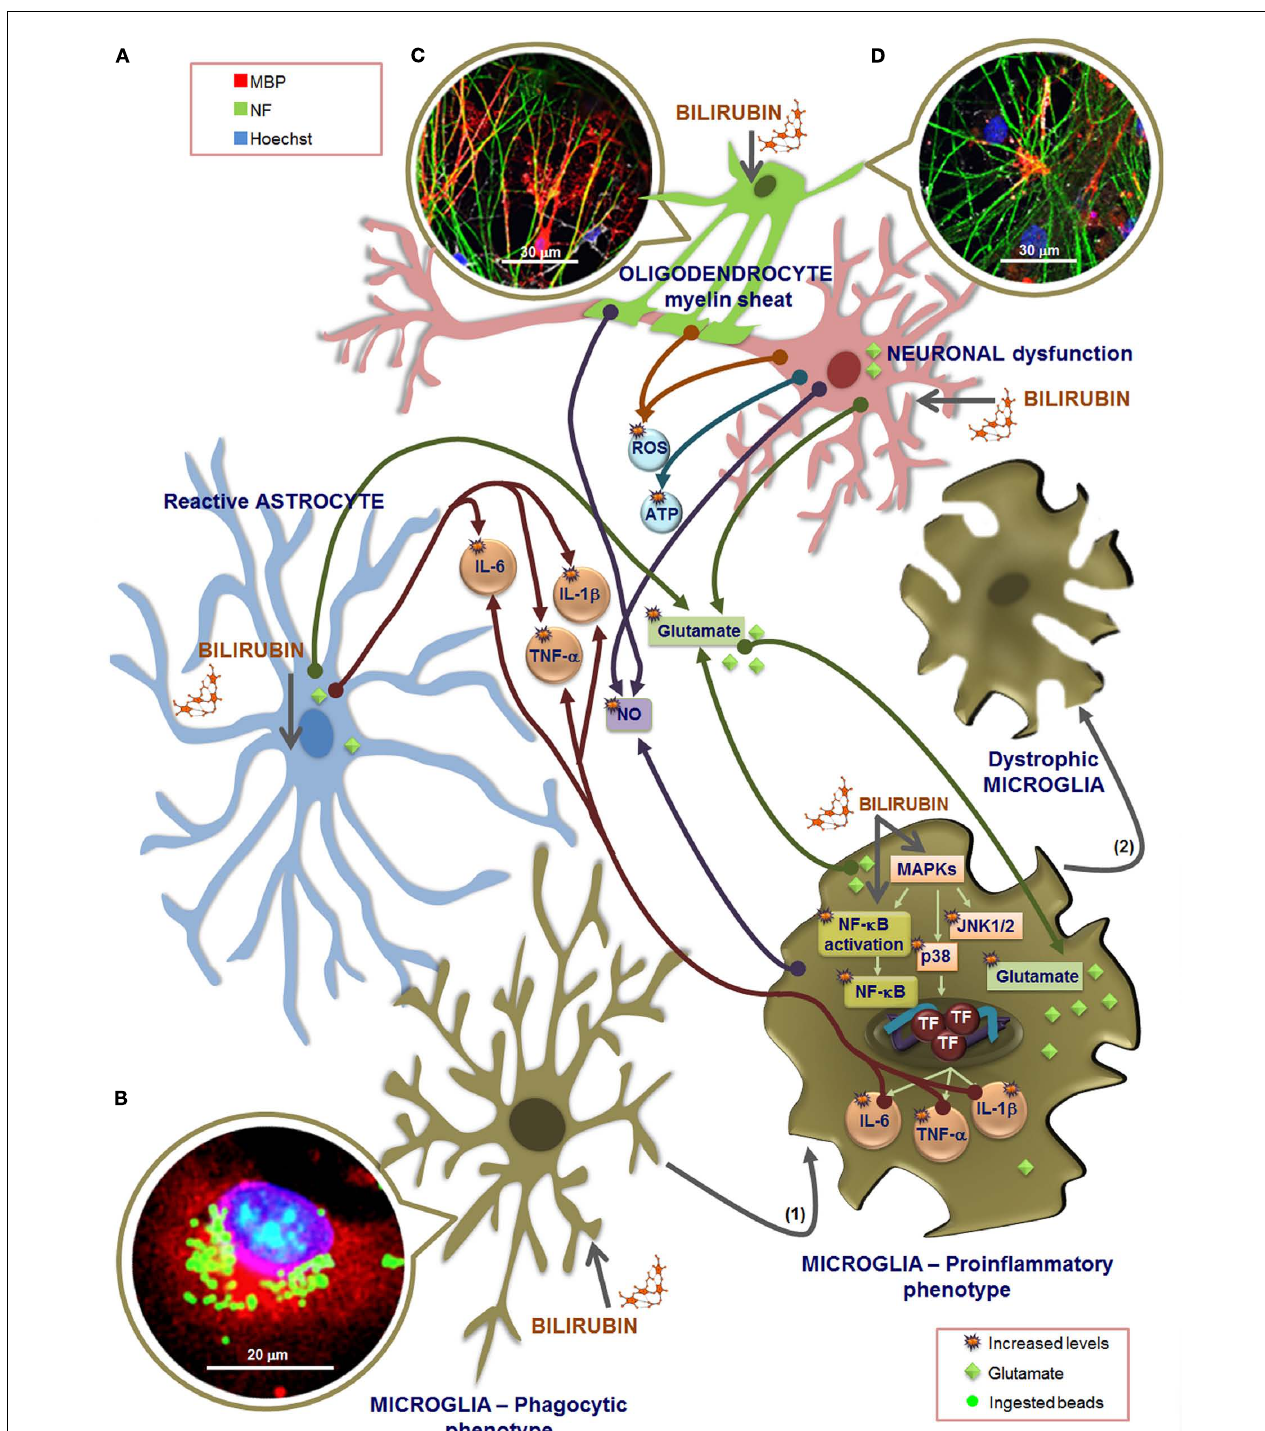
species (ROS) produced by neurons and oligodendrocytes (OLGs), as well as nitrosative stress by nitric oxide (NO) generated by microglia, neurons, and OLGs, and elevated release of ATP from neurons, during exposure to UCB. (B) Phagocytosis upon short stimulation with UCB is visualized in microglia immunostained with an antibody against Iba1 (red) and using Hoechst 33258 stain to visualize the nucleus (blue), by counting the number of ingested fluorescent latex beads (green). Microglia intervenes in glutamate tissue